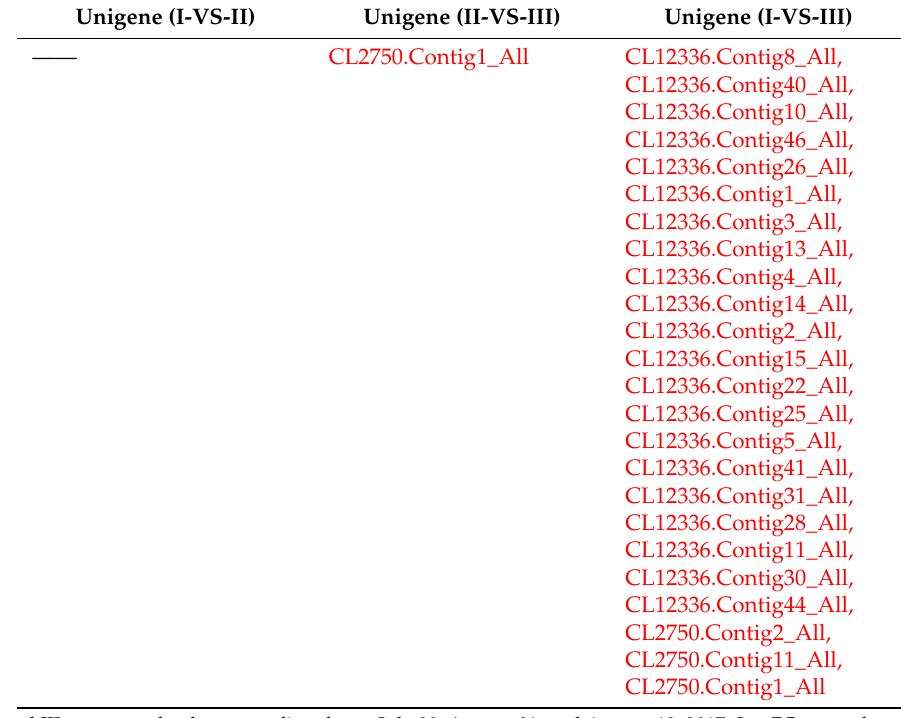
Table 3. List of di ff erentially expressed starch synthase [EC2.4.1.21] genes.